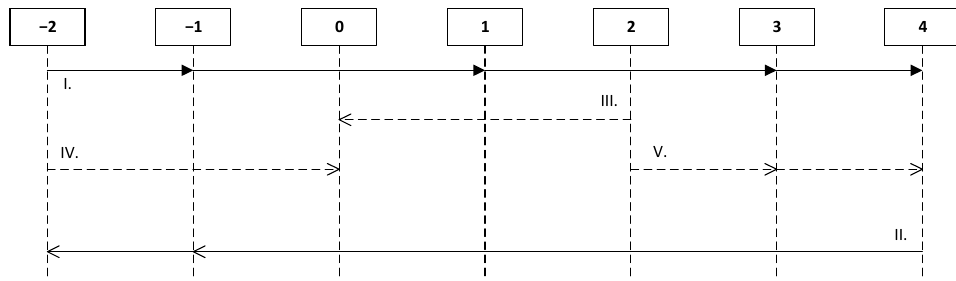
Figure 1. Example of virtual object life cycle diagram. Source: developed by the authors.